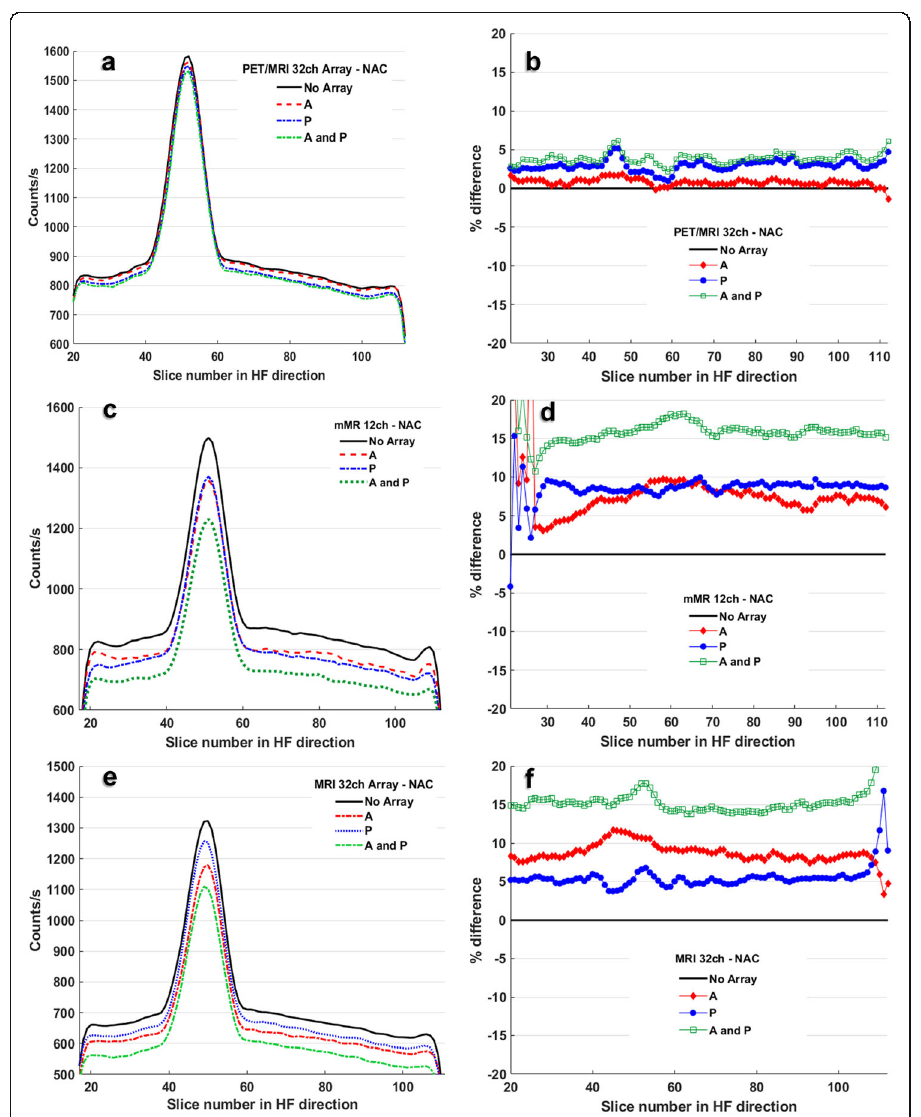
Fig. 2 NAC data are shown in the left column of the figure, with plots showing as counts per second vs the acquisition plane number for all cases A, P, A&P and no-array. Plots are for ( a ) the novel PET/MRI 32ch, ( c ) the mMR 12ch and ( e ) the MRI 32ch arrays. The right column includes the corresponding RPD plots for each array ( b , d and f ) at case A, P and A&P, which resulted from estimation of difference between a mean of an image for each case and mean of its matching image from